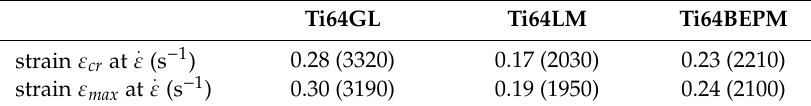
Table 3. Comparison of ε cr and ε max for the tested Ti-alloys.